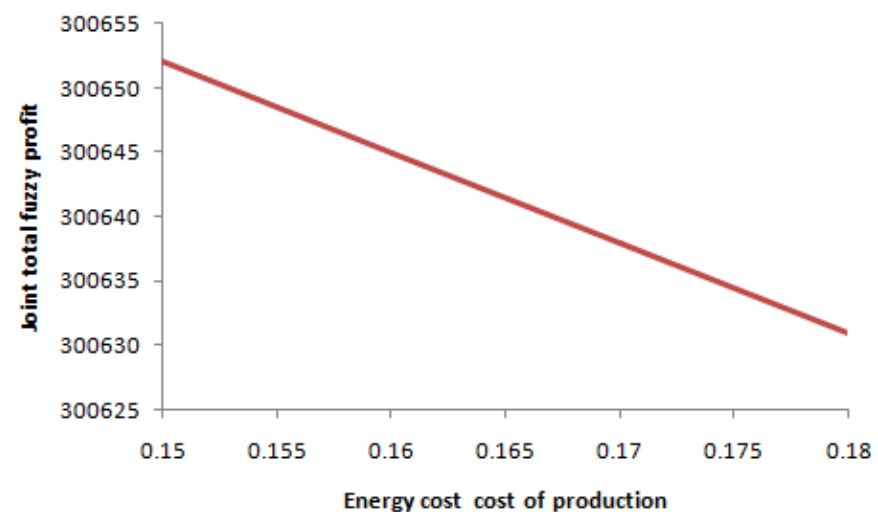
Figure 16. Material and labor cost vs. the joint total fuzzy profit.